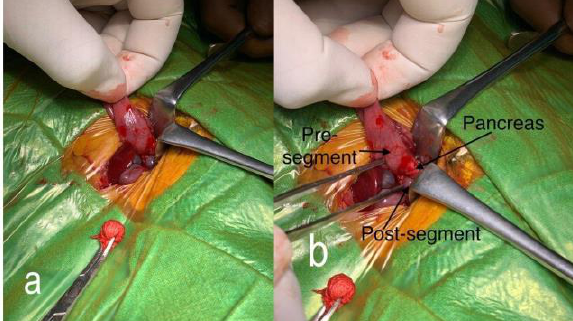
Figure 4a and 4b: Intraoperative photographs showing annular